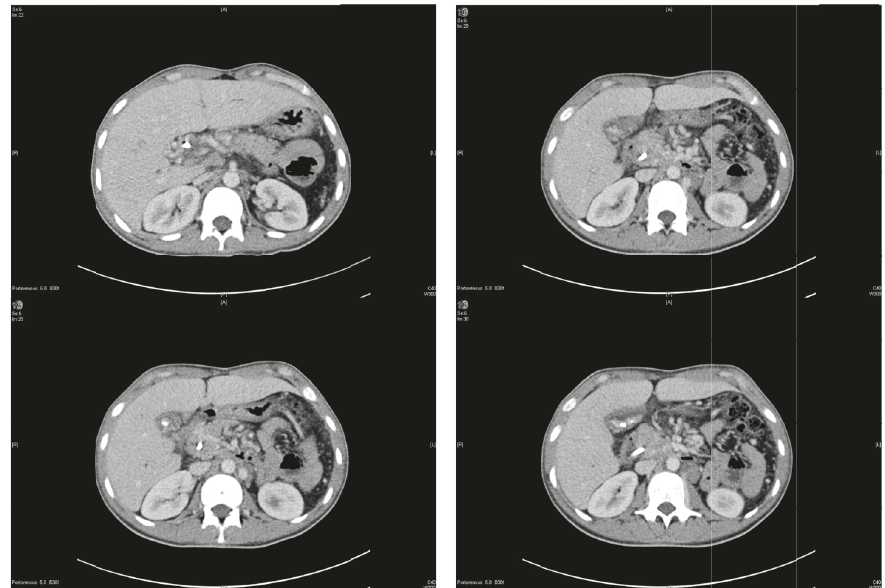
Figure 2: Multipleabdomen computed tomography (CT)scans showing the development of multiple collaterals in theporta hepatis replacing the portal vein, suggestive of cavernous transformation due to chronic portal vein thrombosis, in addition to multiple mesenteric and upper retroperitoneal collaterals. Multiple gallbladder stones and CBD stent are also seen. The liver is seen slightly enlarged with no detectable focal lesions. Normal enhancement of the hepatic veins. Normal size and parenchymal density of the pancreas. No detected gross masses. No detected calcification. Clear peripancreatic fat planes. Status after